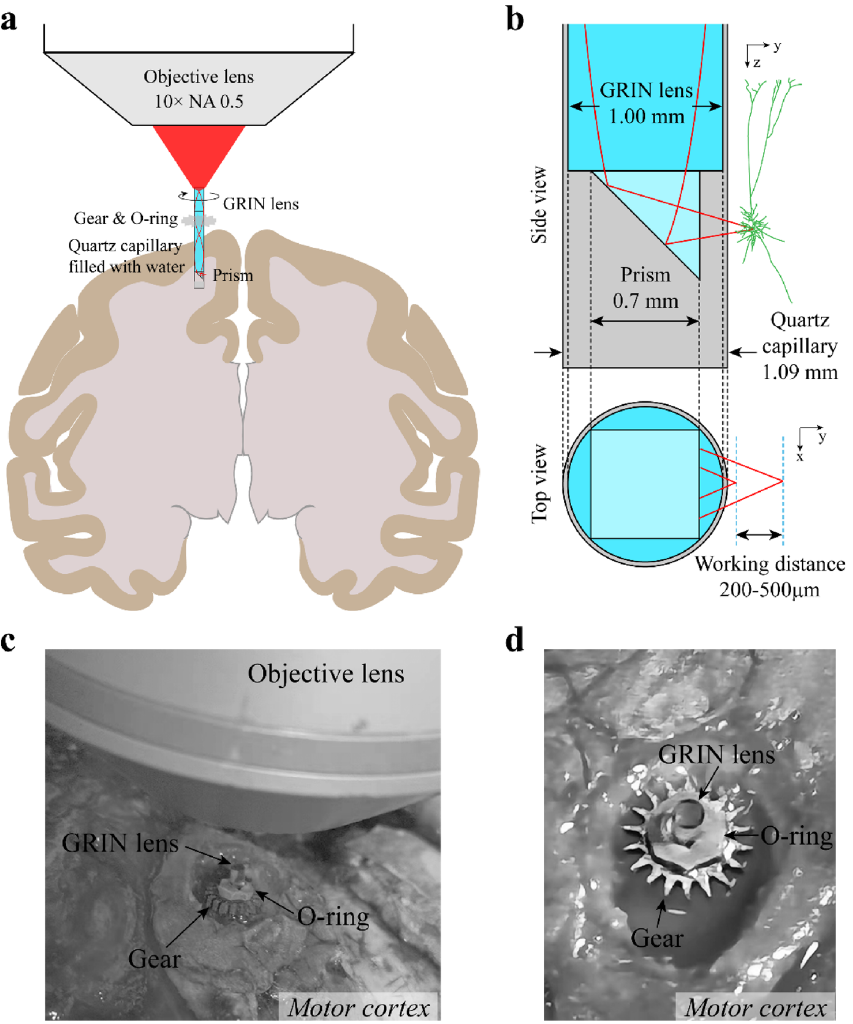
Figure 1. Modified design of COMPACT in large animal. ( a ) Schematic diagram of rotation and translation control for panoramic imaging at different depths. The gear rotates the imaging probe for the panoramic view, and the O-ring surrounds the imaging probe to move the capillary up and down for imaging at different depths in the brain. ( b ) Dimensions of the capillary, imaging probe and the working distance. The imaging probe consists of a 0.5 mm GRIN lens attached to a 0.35 mm prism, or consists of a 1.0 mm GRIN lens attached to a 0.70 mm prism. ( c, d ) Magnified views of the imaging probe, metal gear and O-ring. The schematic diagrams in ( a ) and ( b ) were created using Adobe Illustrator software, version 22.1 (https:// www. adobe. com/ produ cts/ illus trator.